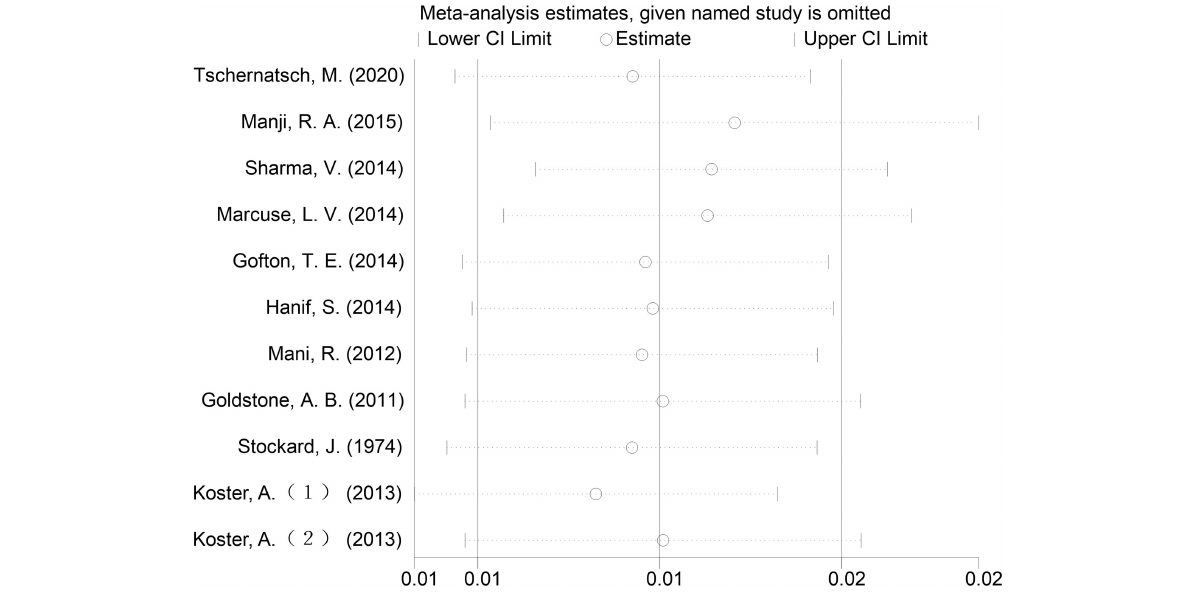
FIGURE10 Influence analysis of cardiopulmonary bypass (CPB) in adults.